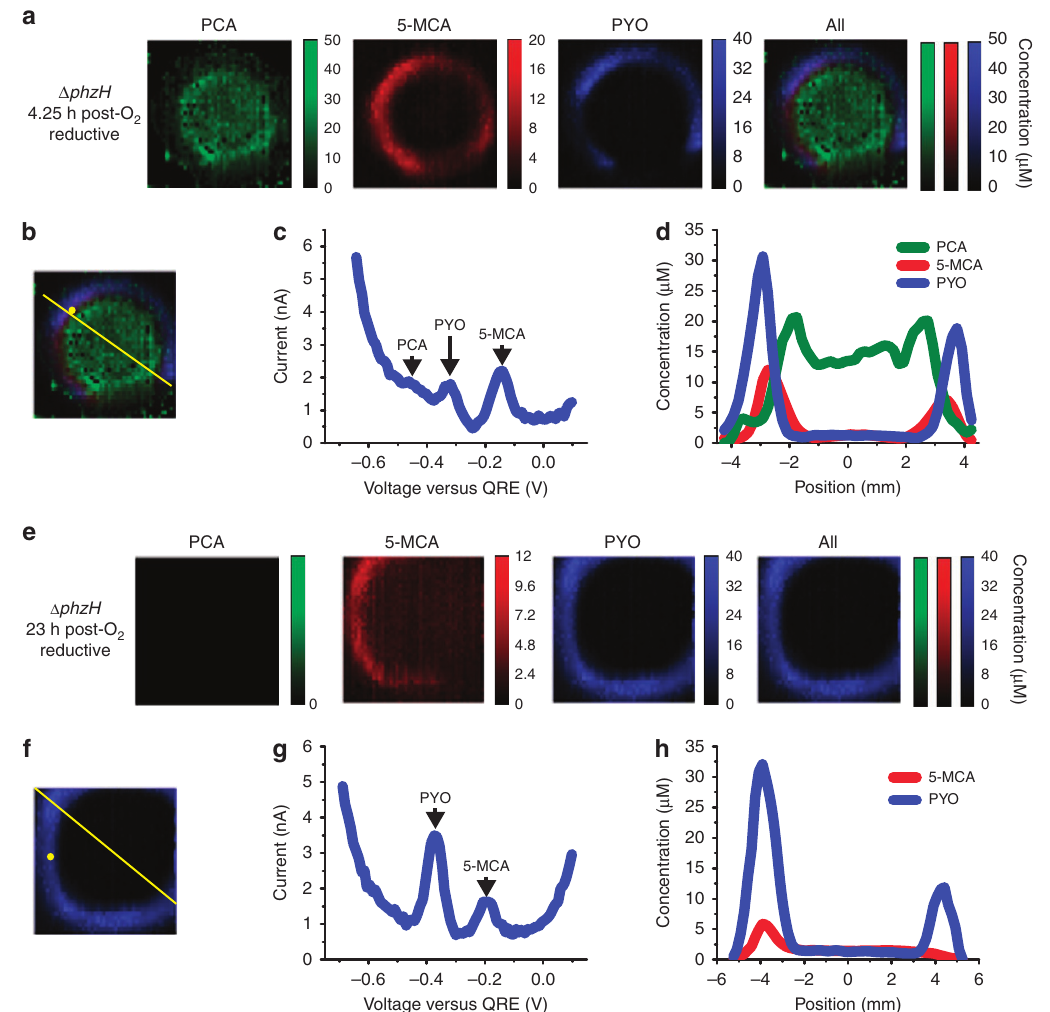
Figure 7 | Electrochemical imaging of anaerobically grown D phzH biofilms following 4.25 and 23h of oxygenation. ( a ) Electrochemical imaging, based on reductive SWV, of a D phzH biofilm after 2 days of anaerobic growth and after 4.25h of subsequent exposure to O 2 . Pixel intensity is proportional to phenazine concentration. PCA is shown in green, 5-MCA in red and PYO in blue. Maximum error due to electrode variability is 18 m M for PCA, 4 m M for 5-MCA and 4 m M for PYO. Images are 8mm (cid:2) 8mm. ( b ) Locations of example square-wave voltammogram and cross-section in c , d , respectively. ( c ) Example square-wave voltammogram from a single electrode. ( d ) Example cross-section from the electrochemical image in a . ( e ) Electrochemical imaging, based on reductive SWV, of a D phzH biofilm after 2 days of growth and after 23h of subsequent exposure to O 2 . Pixel intensity is proportional to phenazine concentration. 5-MCA is shown in red, and PYO in blue. Maximum error due to electrode variability is 4 m M for 5-MCA, and 4 m M for PYO. Images are 8mm (cid:2) 8mm. ( f ) Locations of example square-wave voltammogram and cross-section in g , h ,